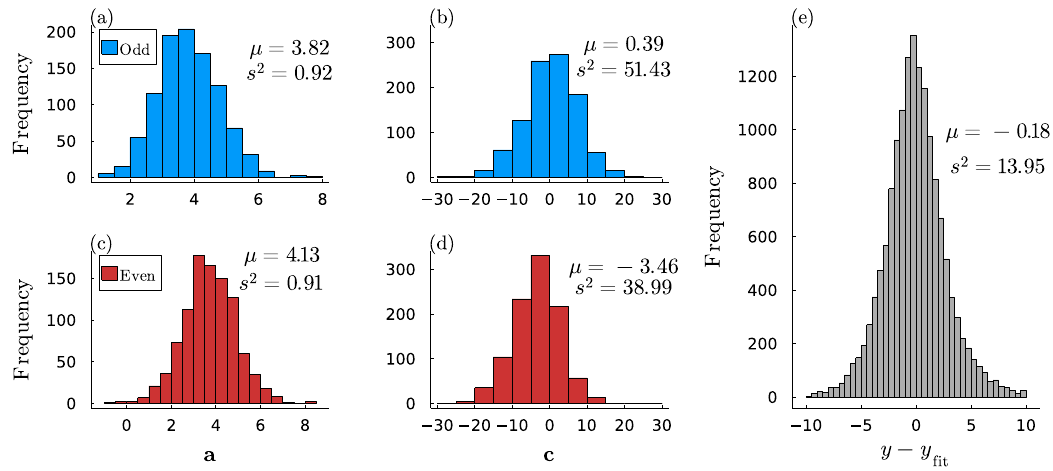
Figure 3: (a)(b) The histograms of the fitted parameters a and c from Eq. (13) for o o the odd branch. (c)(d) The histograms of the fitted data a and c for the even branch. e e (e) The histogram of Γ in Eq. (13), obtained by collecting the difference between the n data and the fitted results y − y for each realization and n ∈ [ 10,40 ] . The Gaussian fit distributions of the histogram supports the conjectured effective randomness of the parameters. We use the b sequence obtained from L = 13 and h = 7 in the range of n n = 10 to 40 for the